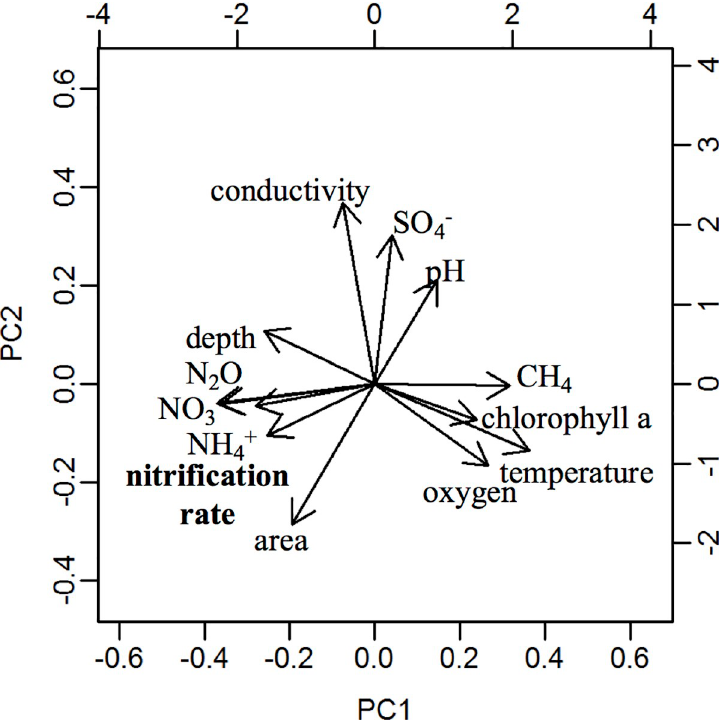
Fig 5. Principal component analysis showing the relationship between measured variables and nitrification rates. PC1 and PC2 account for 61% of the variance exhibited by the relationship among these variables. Within a PCA, the closer the component vectors are (angle and length) the more closely they are related. Note the association of nitrification rates with NO 3– , N 2 O and NH 4+ , and of CH 4 with chlorophyll and temperature.